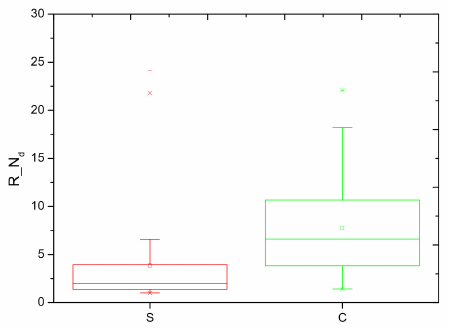
Figure 7. Statistics of R _ N d in the stratiform cloud region and the convective cloud region. Table 2. Statistical information for R _ N d of the stratiform region and the convective region. Cloud Mean Q1 Minimum Median Q3 Maximum